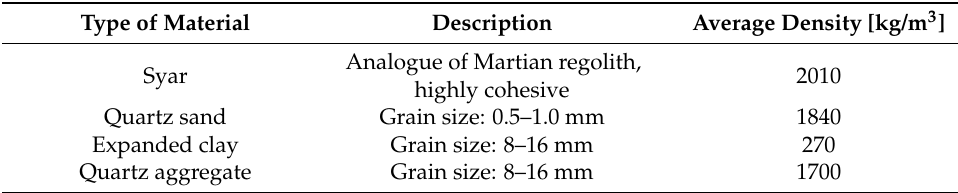
Figure 14. The type of surface materials used in the tests. From left: Syar, quartz sand, expanded clay, quartz aggregate. Table 2. Characteristics of the surface materials used in the